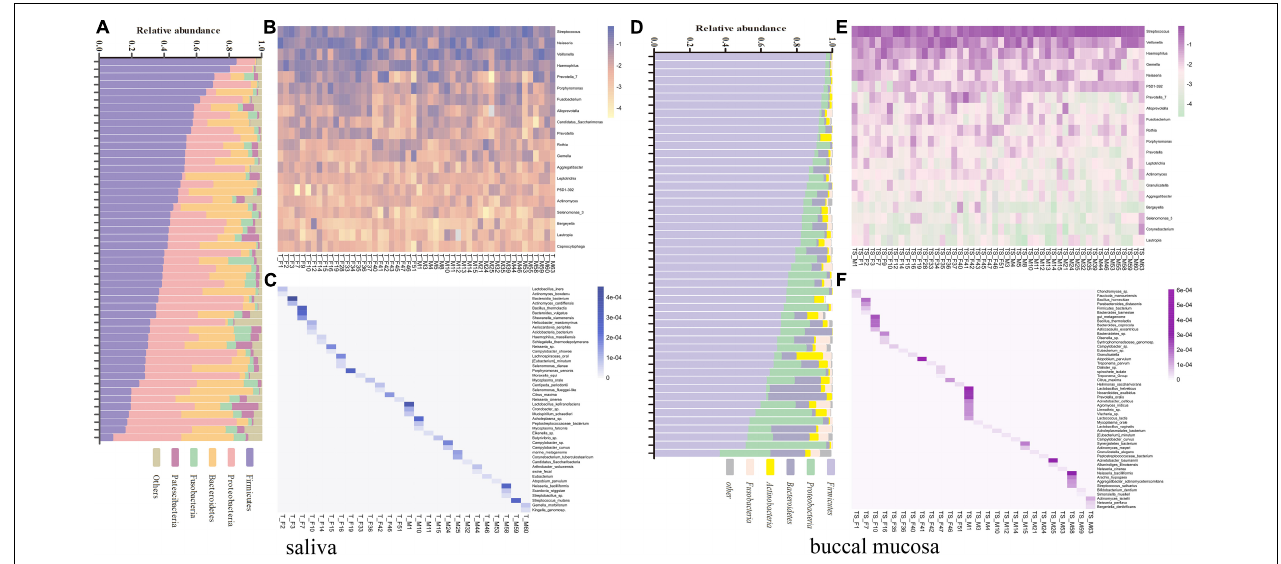
FIGURE 6 | (A) Relative abundance of the five major bacterial phyla of all individual saliva samples, sorted by decreasing Firmicutes content. (B) Heatmap of the top 20 bacterial genera of all individual saliva samples according to the raw relative abundance. (C) Heatmap of the relative abundance of 47 specific bacterial species among 26 individual saliva samples according to the raw abundance value. (D) Relative abundance of the five major bacterial phyla of all individual buccal mucosal samples, sorted by decreasing Firmicutes content. (E) Heatmap of the top 20 bacterial genera of all individual buccal mucosal samples according to the raw relative abundance. (F) Heatmap of the relative abundance of 47 specific bacterial species among 26 individual buccal mucosal samples according to the raw abundance